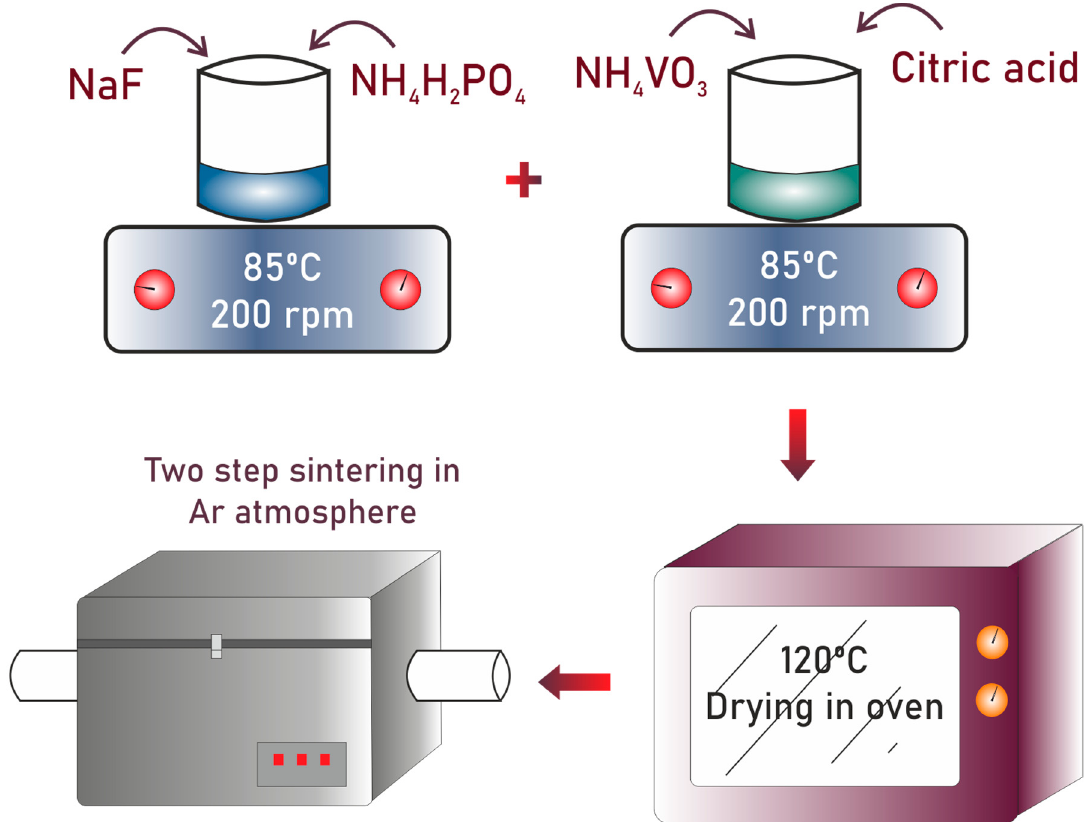
Figure 8. Schematic diagram showing experimental setup for synthesis of NVPF material.